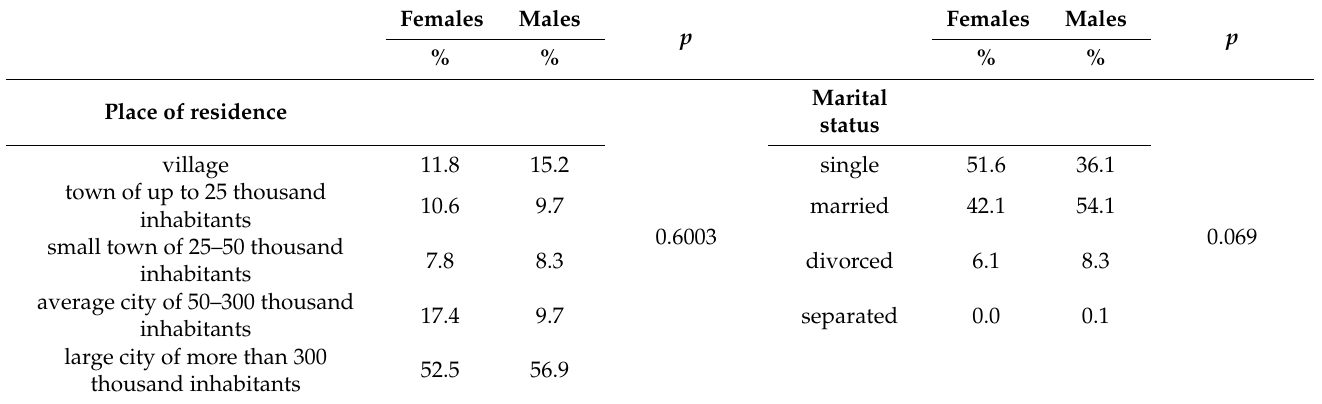
Table 1. Socio-demographic